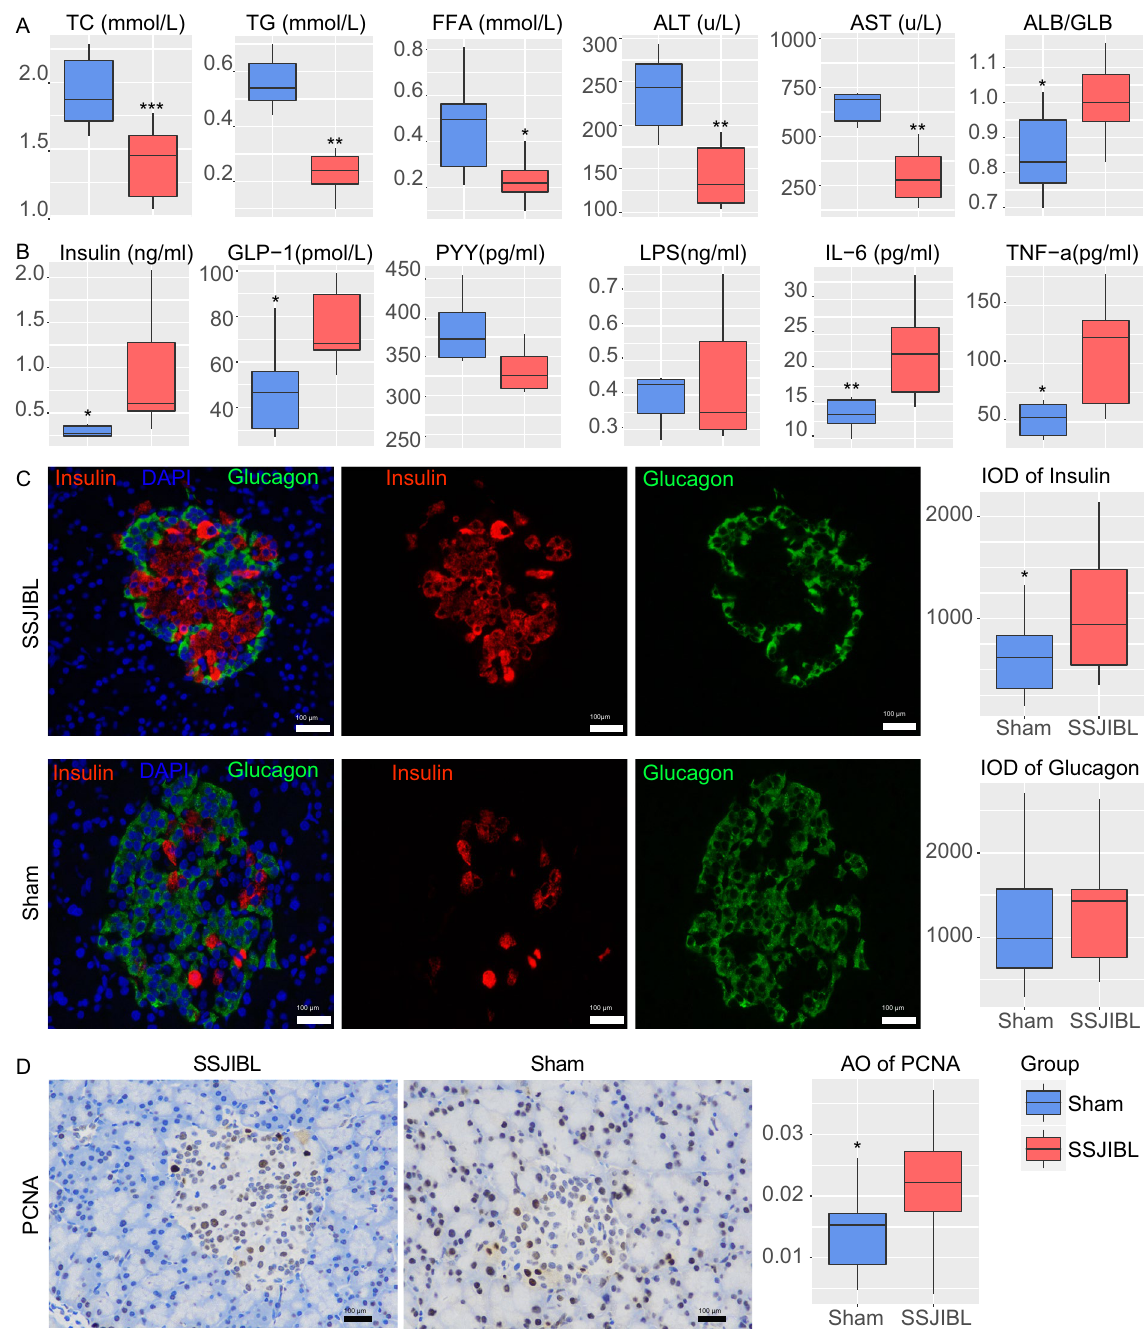
Figure 2. SSJIBL improves lipid homeostasis and liver function, promotes the release of hormones such as insulin and glucagon-like peptid-1, and stimulates the proliferation of pancreatic islet cells. ( A ) Total TC, TG, FFA, ALT, AST, and ALB/GLB levels in blood. ( B ) Insulin, GLP-1, PYY, LPS, IL-6, and TNF-α levels in blood. ( C ) Representative pictures of immunofluorescence of pancreatic tissue (scale bar, 100 μm). Right, integrated optical density ( D ). Representative pictures of immunohistochemistry of pancreatic tissue (scale bar, 100 μm). Right, average optical density (AO). Error bars are expressed as means ± SEM. Statistical significance was determined by two-tailed Student’s t test. * P < 0.05, ** P < 0.01, *** P <